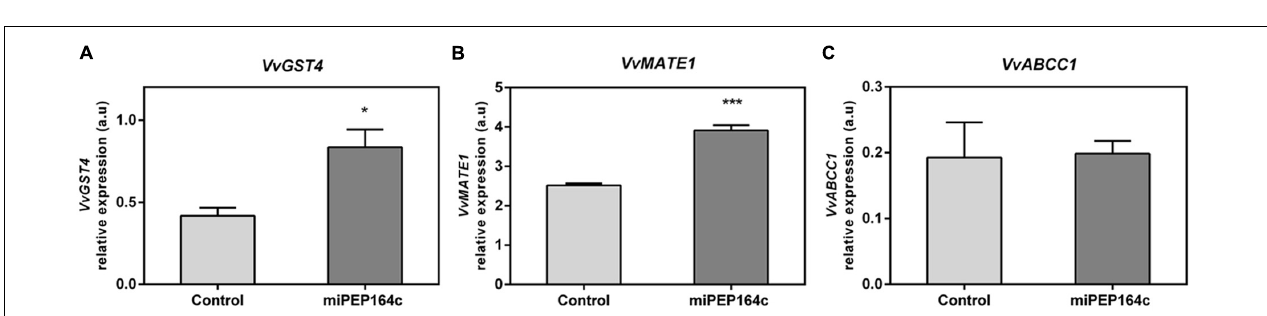
FIGURE 6 | Steady-state transcript levels of VvDFR (A) and VvLDOX (B) in suspension-cultured grape berry cells (cv. Gamay) 10-day after elicitation with 1 µ M miPEP164c. Gene expression analysis, by real-time qPCR was normalized with the expression of reference gene VvACT1 and VvGAPDH . Values are the mean ± SEM. Asterisks indicate statistical significance (Student’s t -test; * P < 0.05; ** P < 0.01).